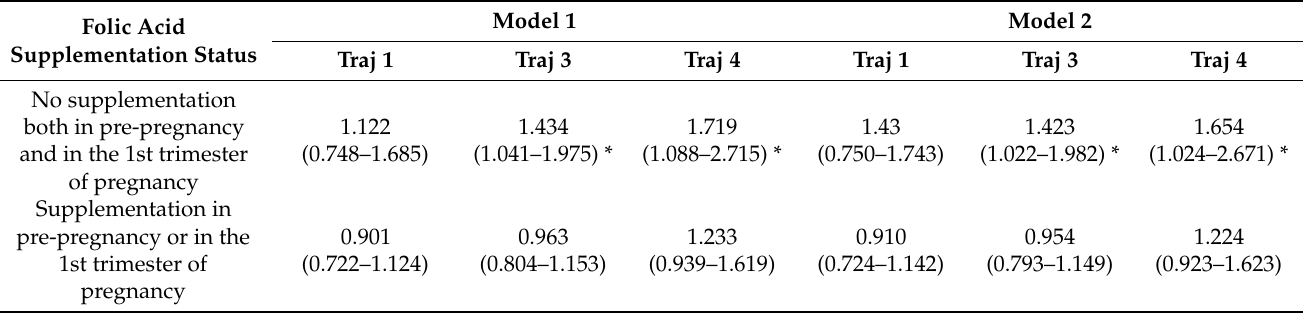
Table 2. Association of peri-conceptional folic acid supplementation status with BMI-Z trajectory in children 0–6 years of age [n = 3000, OR